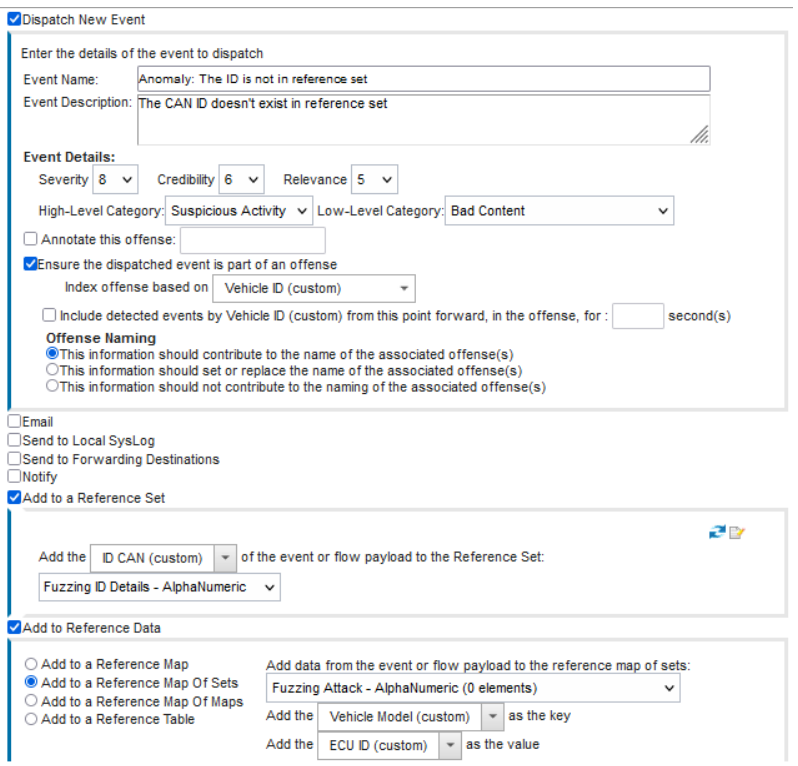
Figure 16. The actions chosen for the fuzzing attack.